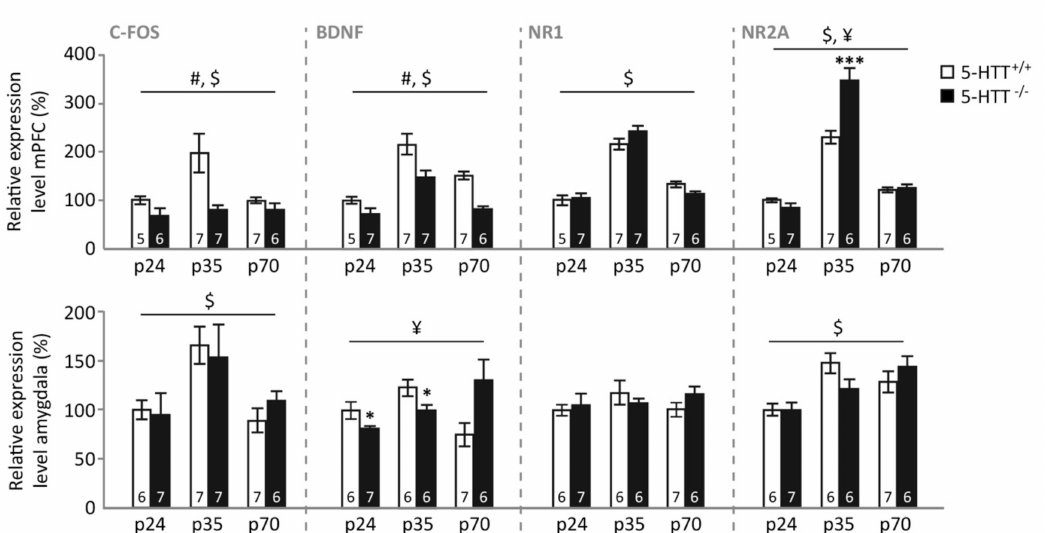
Figure 3. Relative expression levels of c-Fos, BDNF, NR1, and NR2A in the medial prefrontal cortex (mPFC) and amygdala of naive preadolescent (p24), adolescent (p35), and adult (p70) 5-HTT − / − and 5-HTT +/+ rats. #: a significant e ff ect of genotype ( p < 0.05); $: a significant e ff ect of age ( p < 0.05); ¥: a significant age × genotype interaction ( p < 0.05); *: a significant post hoc di ff erence between 5-HTT − / − vs. age-matched 5-HTT +/+ rats (* p < 0.05; *** p <